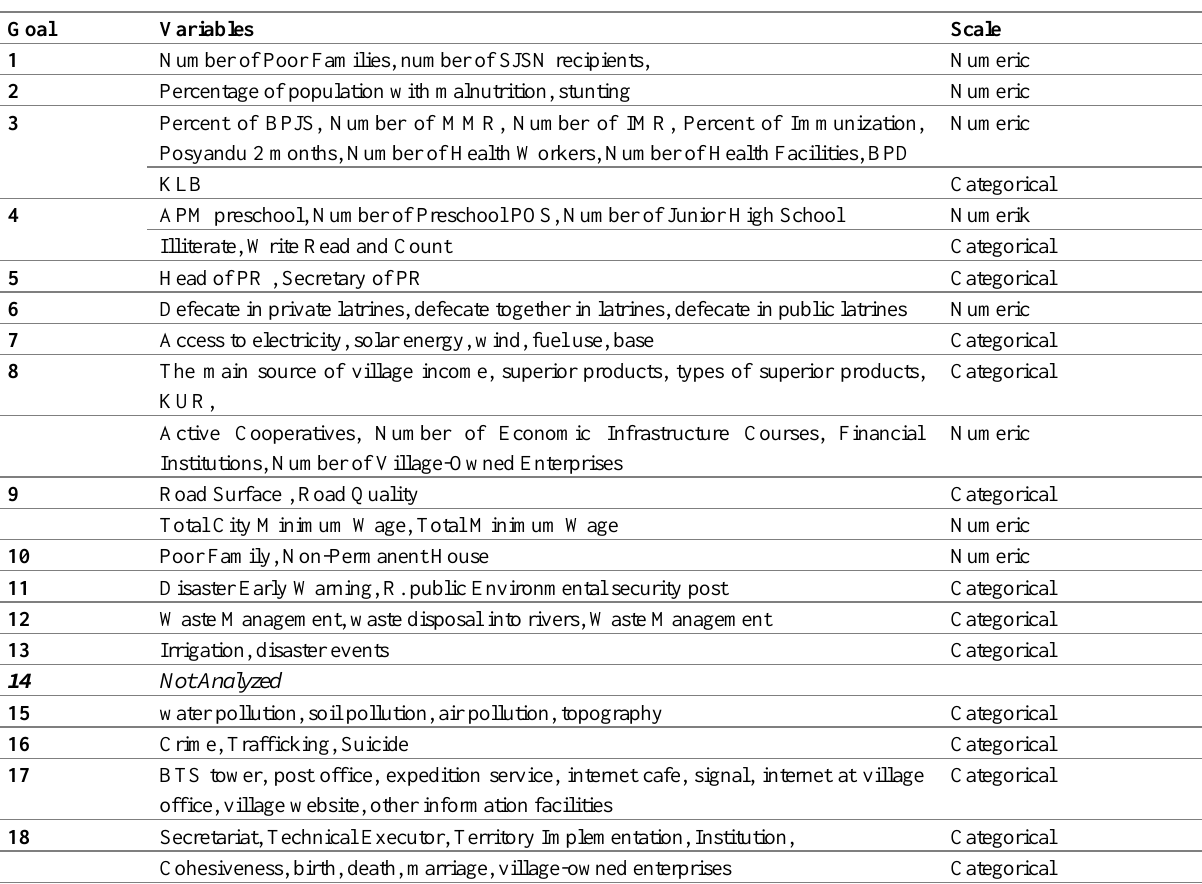
Table 1: Research